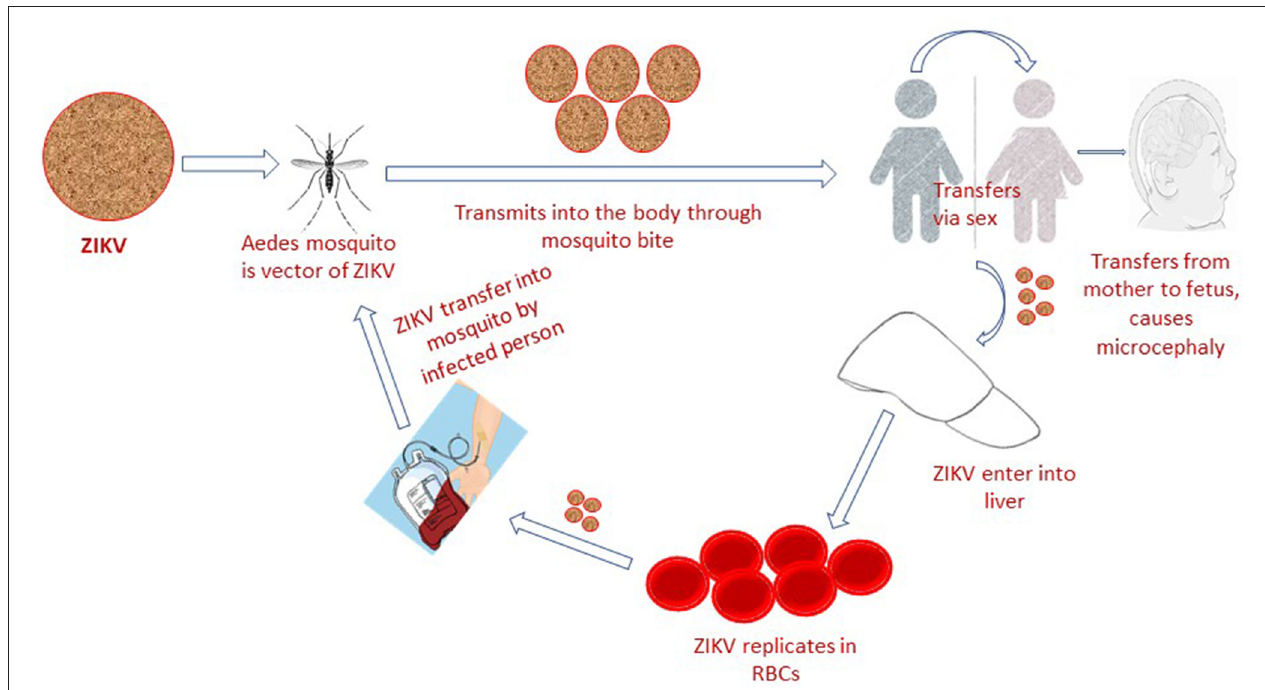
FIGURE 1 | Zika virus infection is transmitted to human population via mosquito bite, blood transfusion, sexual intercourse, and from mother to fetus.